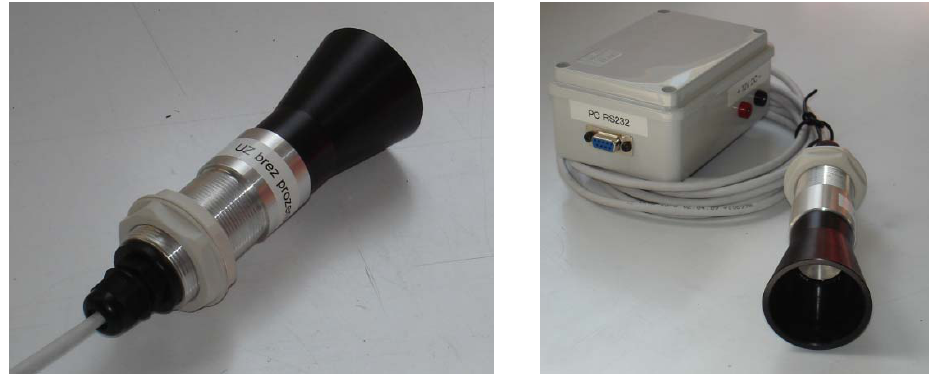
Figure 2. Ultrasonic sensor with ultrasonic transceiver built in the horn. The enclosure includes sensor